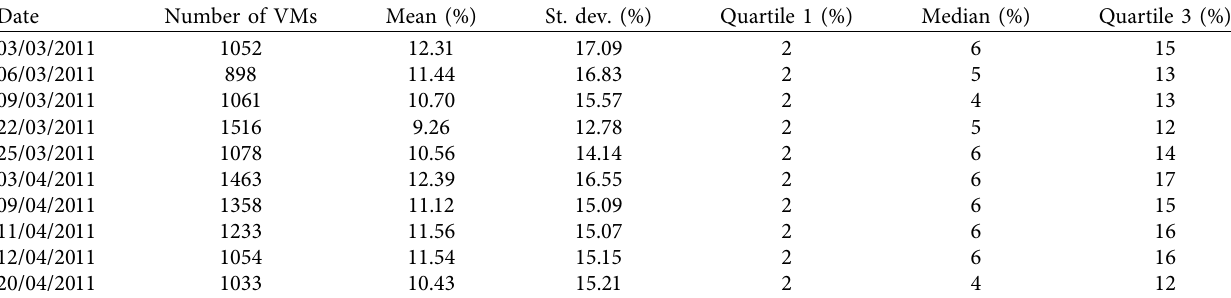
Table 2: Workload data characteristics.